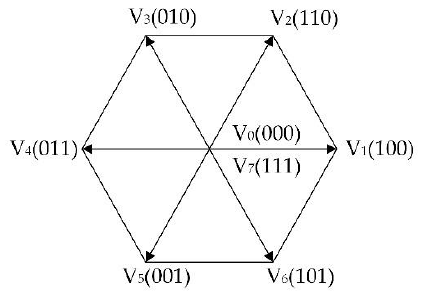
Figure 3. Spatial voltage vector.